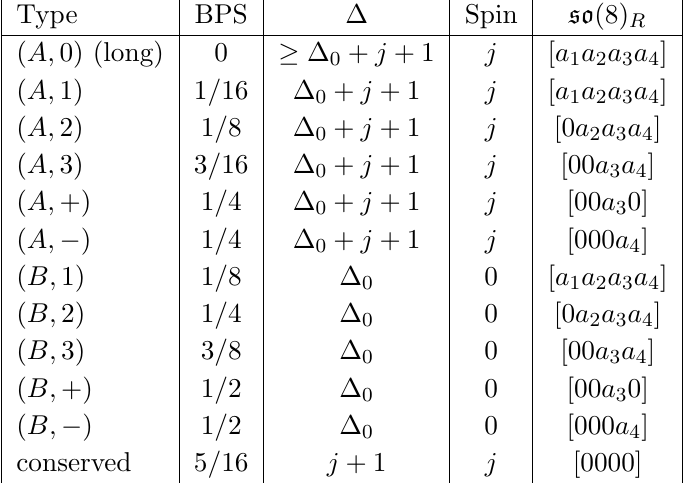
Table 1 . Multiplets of osp (8 j 4) and the quantum numbers of their corresponding superconformal primary operator. The conformal dimension (cid:1) is written in terms of (cid:1) 0 (cid:17) a 1 + a 2 +( a 3 + a 4 ) = 2. The Lorentz spin can take the values j = 0 ; 1 = 2 ; 1 ; 3 = 2 ; : : : . Representations of the so (8)